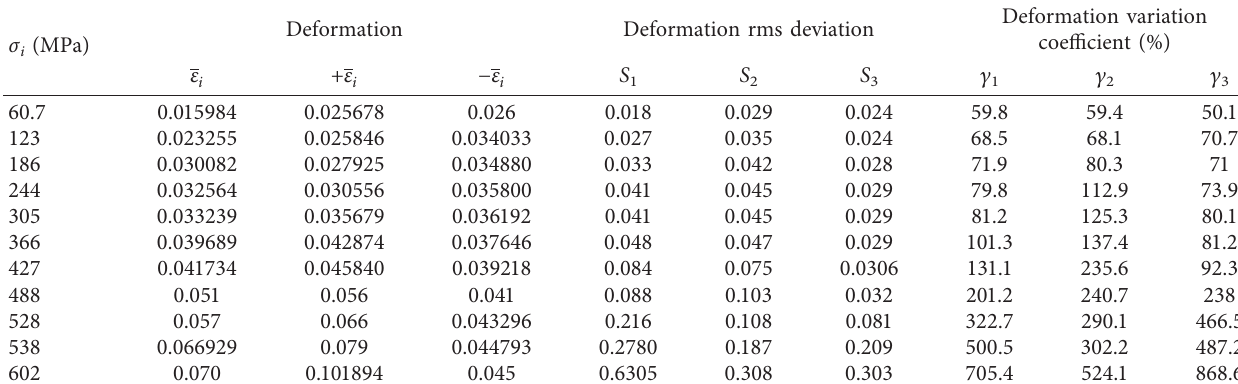
Table 6: Experimental data characterizing the microplastic deformation of deposited samples of steel 530H40 after annealing (group I). σ i